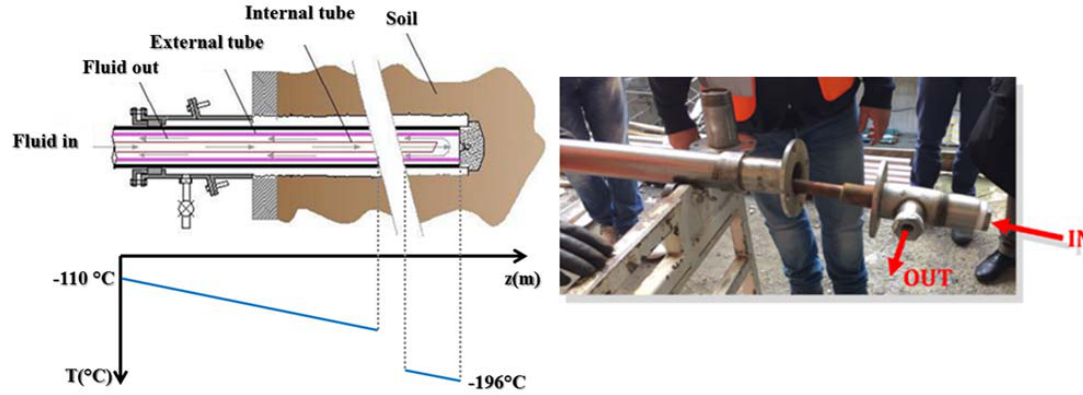
Figure 5. Freezing probe configuration and refrigerant direction: ( left ) scheme of freezing probe and temperature profile along the probes; ( right ) picture of the actual freezing probe.